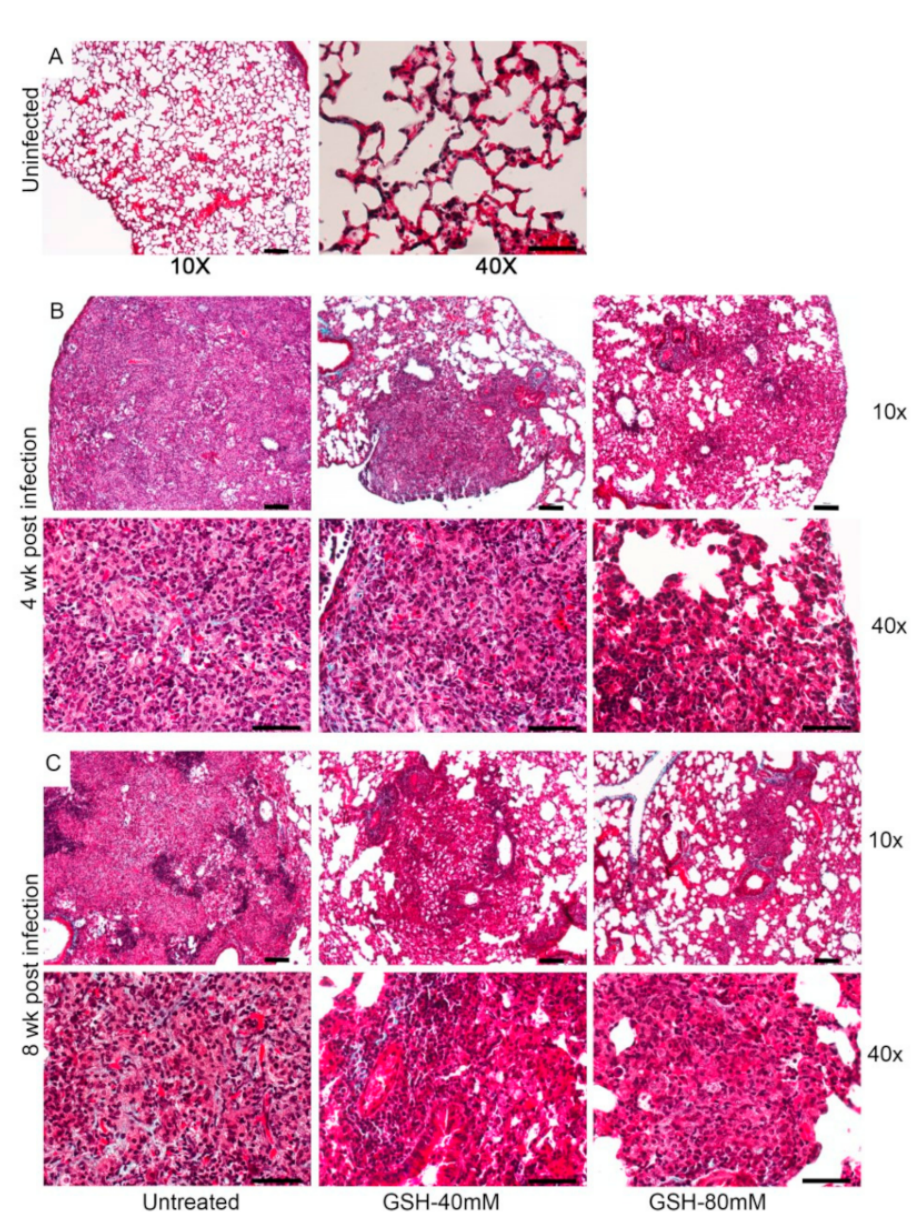
Figure A2. Images of the lung granuloma histology in M. tb -infected untreated and L-GSH-treated mice (40 mM and 80 mM L-GSH treatment). The images are of mice euthanized at 3 h post-infection ( A ), 4 weeks post-infection ( B ), and 8 weeks post-infection ( C ). The lung sections were stained with Masson’s trichrome staining to visualize the fibrosis and collagen deposition. The images are magnified at 10 × and 40 ×